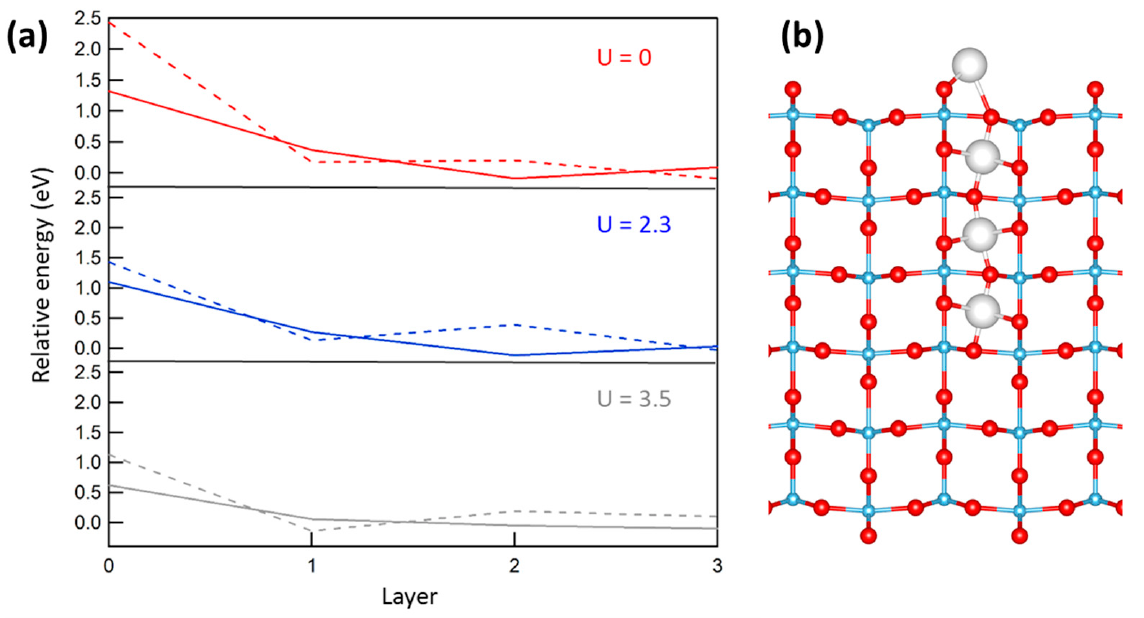
Figure 2. ( a ) Relative energy for an excess Ti atom at the TiO 2 (110) surface as a function of the occupied layer. Layer = 0 stands for adatom sites. Solid lines indicate A-type sites, dashed lines indicate B-type sites (see text). ( b ): lateral view of the slab, where A-type interstitial sites are shown as large grey spheres. U values in eV.